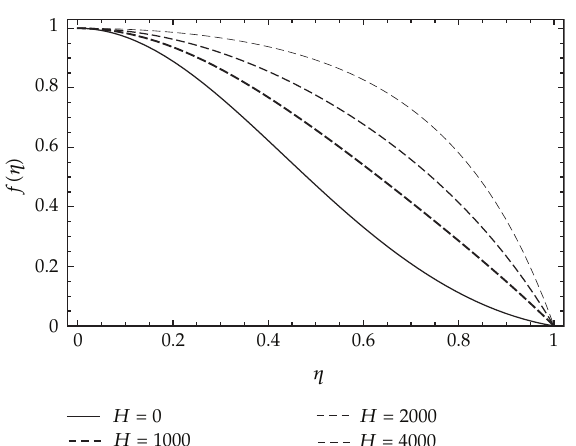
Figure 5: DTM solution for velocity in divergent channel for Re (cid:8) 100 and α (cid:8) 5 ◦ .